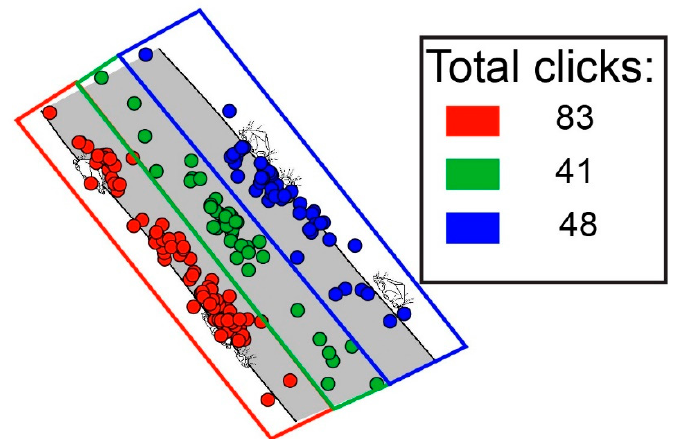
Figure 9. Polygons and student clicks in response to the prompt, “Click in the river where you expect to find the greatest rate of erosion in the riverbed”. The correct region, labeled in green ( n = 41), is the middle of the river channel. The region labeled in red ( n = 83) and green ( n = 48) will have relatively lower velocity and erosion.